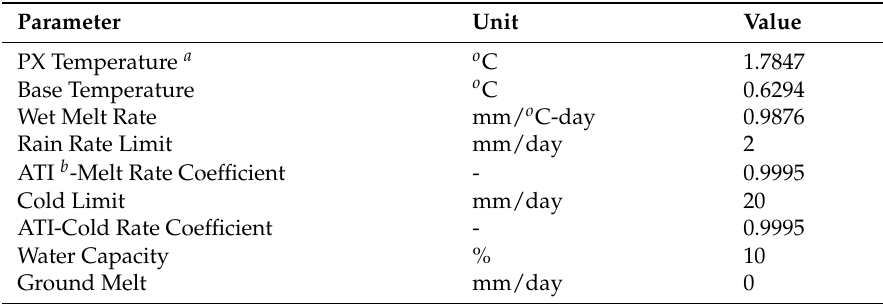
Table 2. Snow melt input parameters for the temperature index